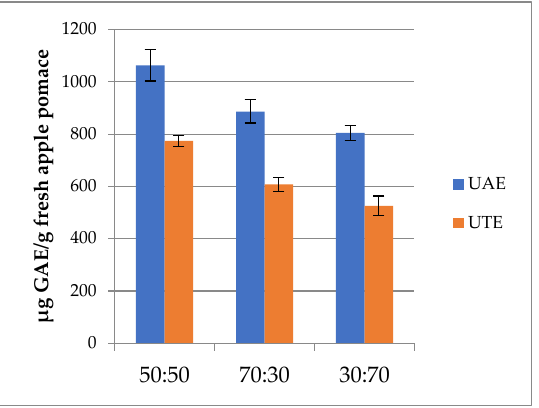
Figure 1. TPC results of UAE and UTE extracts. Error bars represent the SD.